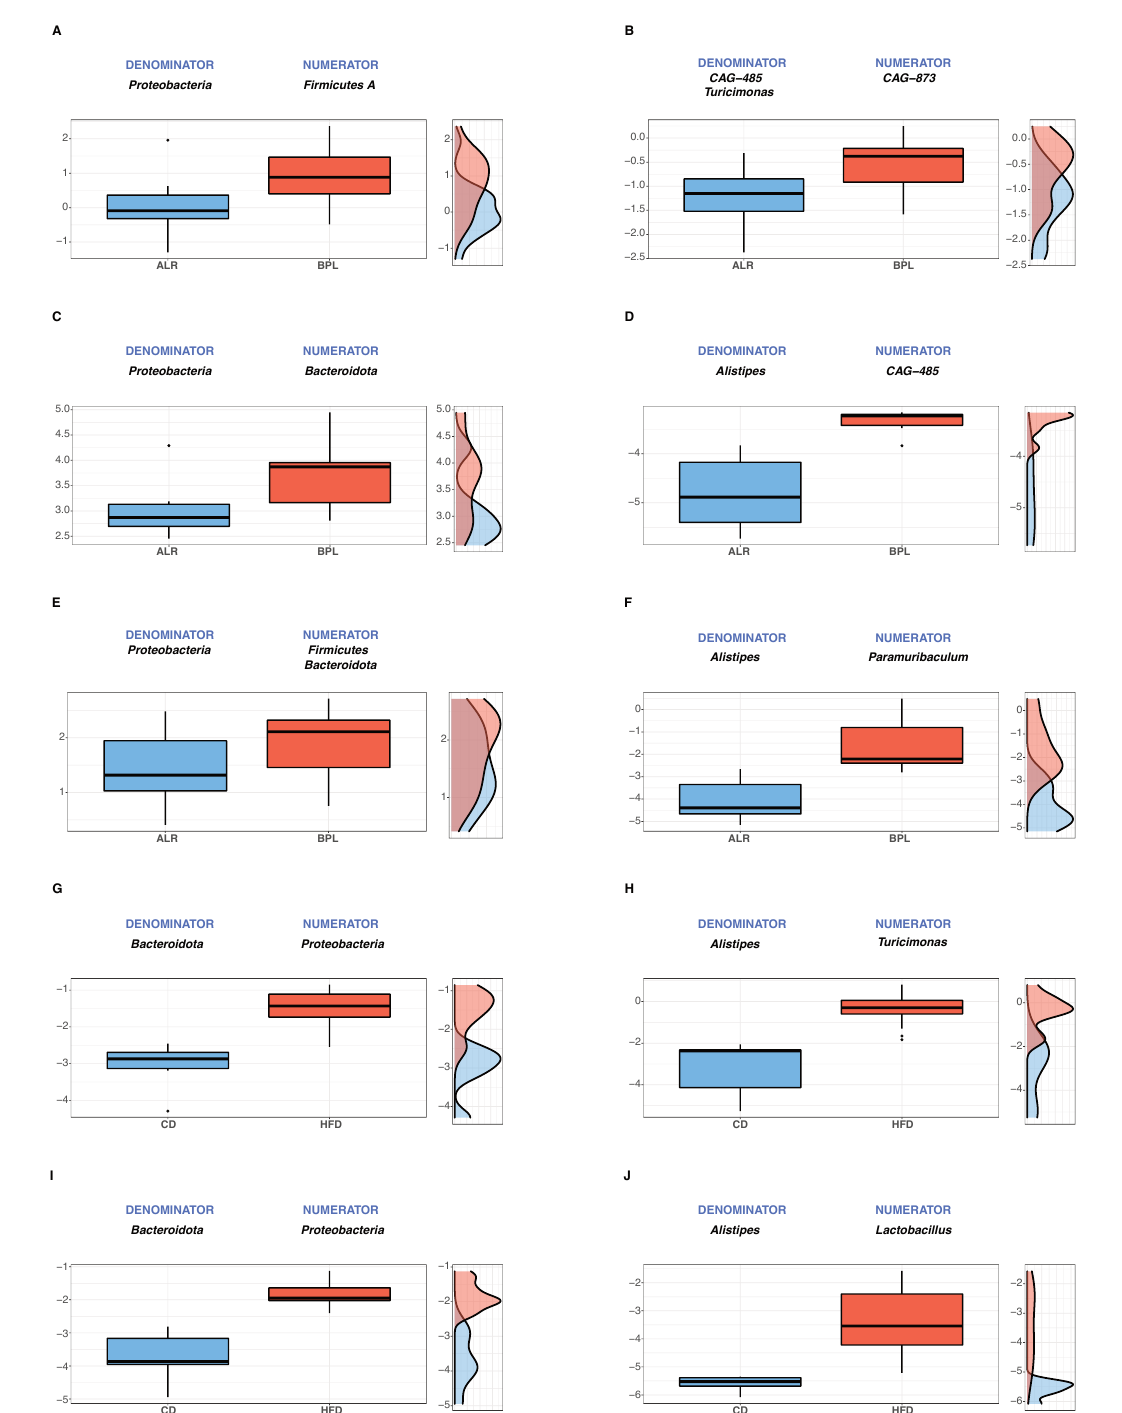
Figure 3. Description of the global balance of bacterial taxa between strains and dietary conditions. The two groups of taxa that form the global balance (defined as denominator and numerator) are specified at the top of the plot. The box plots depict the distribution of the balance score and the density of each distribution is shown next to the box plot for each compared group. The y -axis of the plots indicates the balance score. ( A , C , E , G , I ) show the analysis at the phylum levels, while ( B , D , F , H , J ) are at the genus level. Comparison between B6-mt BPL and B6-mt ALR mice at week 0 (phylum level A , genus level B ), CD-fed for 8 weeks ( C , D ), HFD-fed for 8 weeks ( E , F ). Comparison between HFD and CD groups in B6-mt ALR ( G , H ) and B6-mt BPL ( I , J